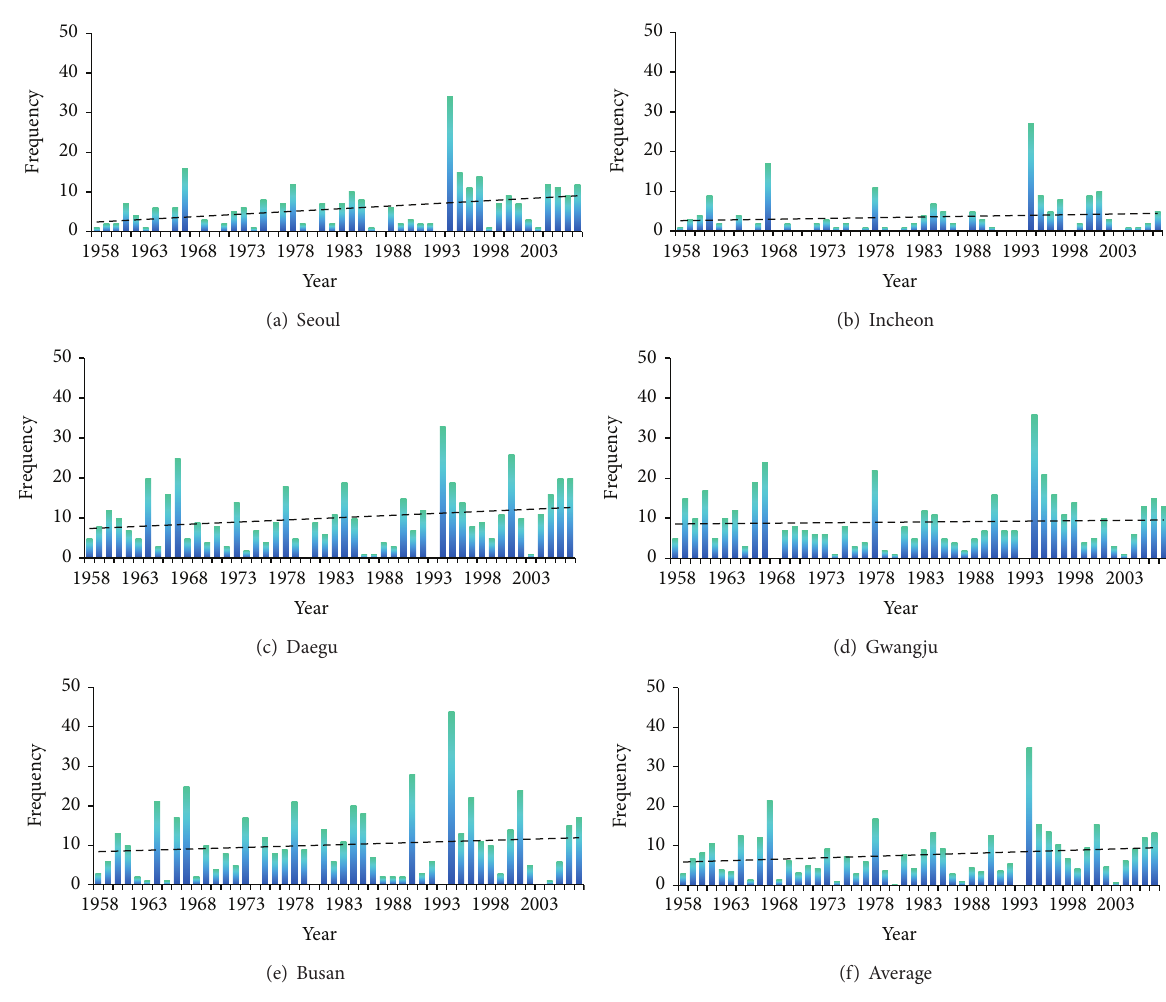
Figure 2: Interannual variation in TN days and their linear trends in the five cities in Republic of Korea.